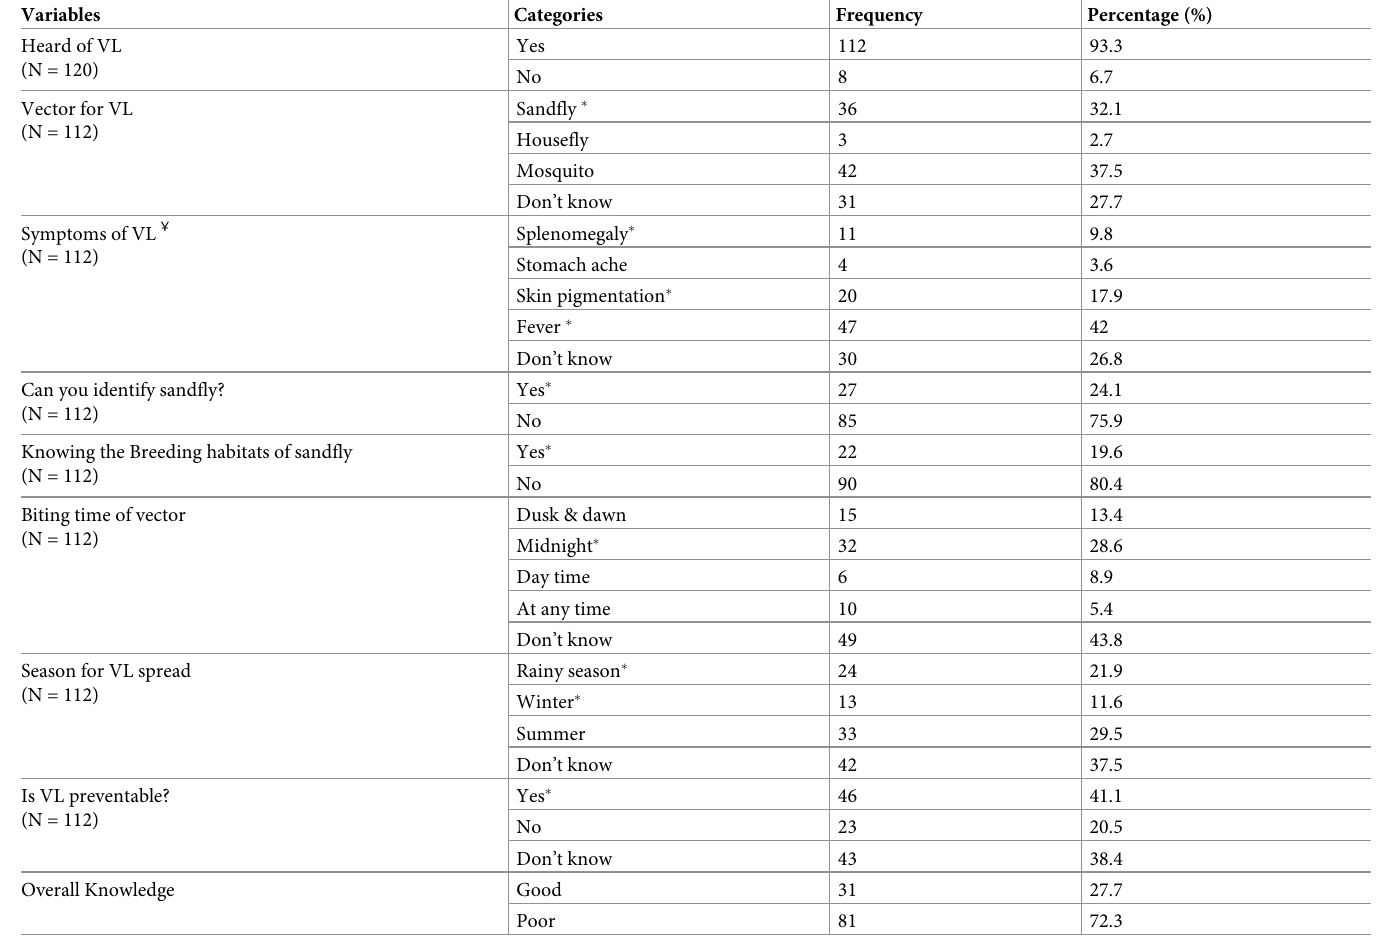
Table 2. Knowledge of study participants about visceral leishmaniasis (N =